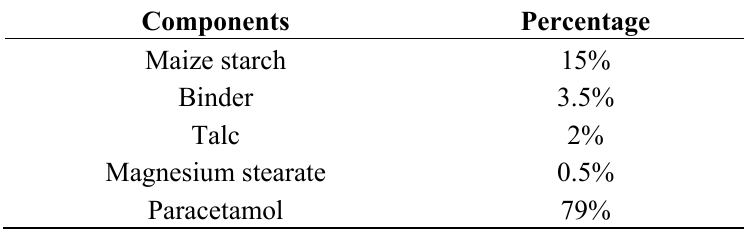
Table 5. Composition of granules for tablet